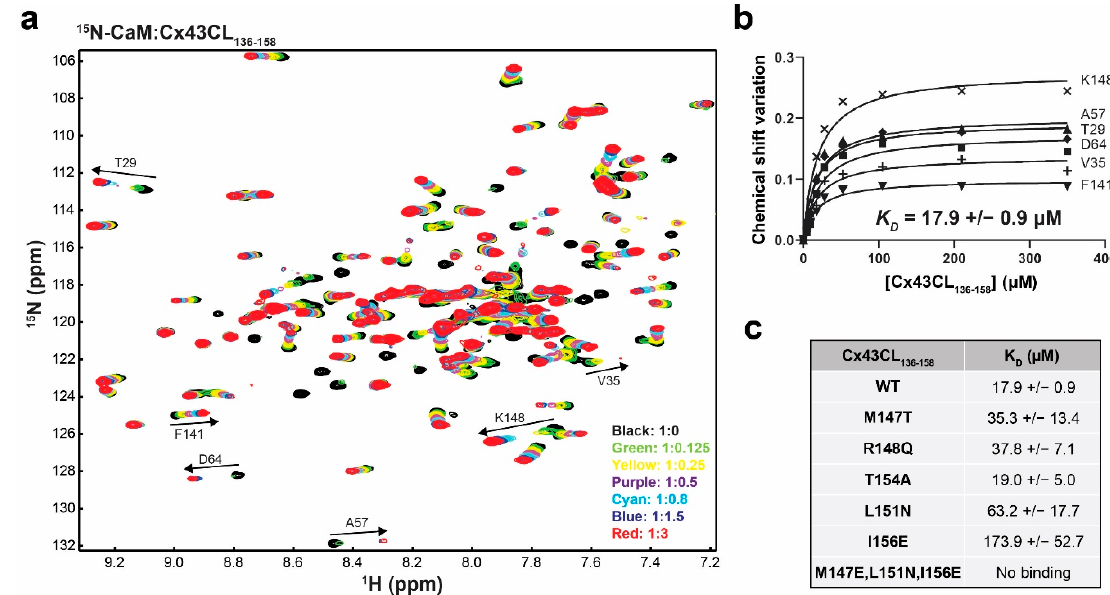
Figure 5. Impact of the Cx43CL ODDD mutations M147T, R148Q, and T154A on the interaction with CaM. ( a ) Example of an NMR titration experiment. 15 N-HSQC spectrum of 15 N-labeled CaM alone (black) has been overlaid with spectra collected in the presence of increasing molar ratios of unlabeled Cx43CL 136-158 WT peptide (ratios indicated in the lower right corner). The residues used to calculate the dissociation constant (K D , panel b ) have been labeled. ( b ) Example calculation of the K D . Representation of the binding isotherms for six residues. Final K D and standard deviation were calculated by averaging the individual K D obtained for each residue after plotting and linear fitting their ∆ σ values. ( c ) Summary of the K D obtained for the interaction of CaM with Cx43CL 136-158 peptides containing various